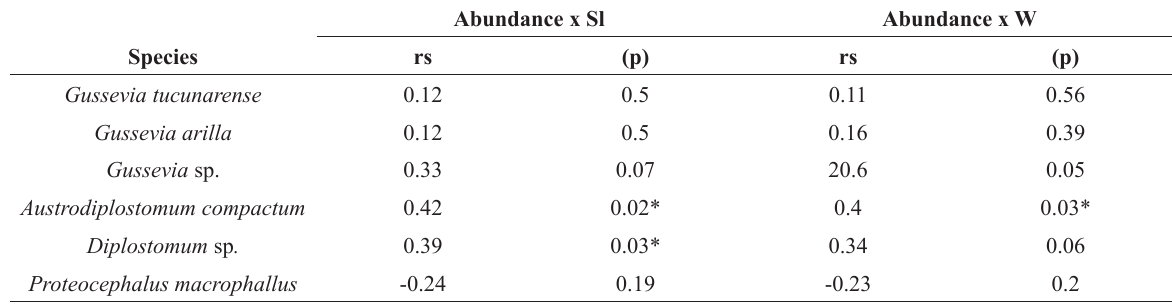
Correlation between parasitic abundance and Standard length (SL) and weight (W) of Cichla ocellaris Bloch & Schneider, 1801 collected in Jacaré-Pepira River, State of São Paulo, Brazil.